Question: Sum up the contents of this chart in one sentence.
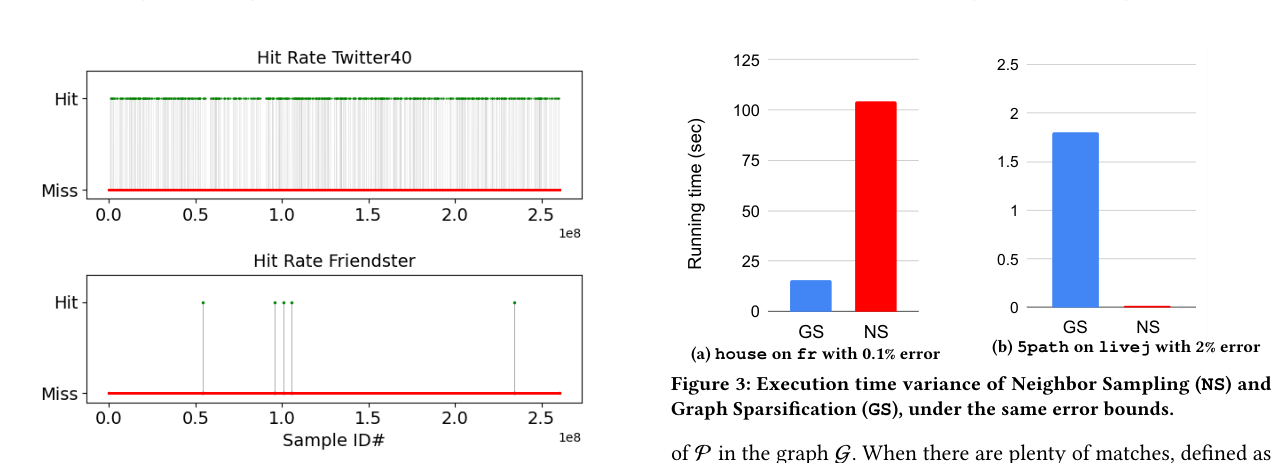
Answer: Sample hits and misses in Arya, on Twitter40 (top) and Friendster (bottom) graphs. The pattern is 4-clique for both. In total 108 samples are drawn in both cases. Each green point is a hit sample, while each red point is a miss sample. For Twitter40, there are 7,033 hits with a hit rate of 7 × 10−5. For Friendster, there are only 5 hits with a 5 × 10−8 hit rate (i.e. needle in the hay).